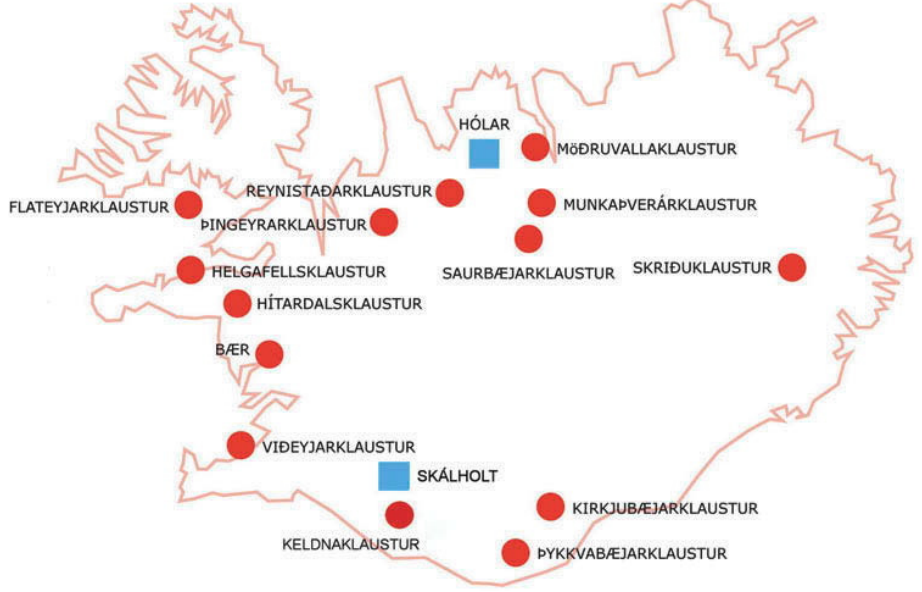
Figure 1. Medieval Icelandic monasteries and nunneries (red), and bishoprics (blue).